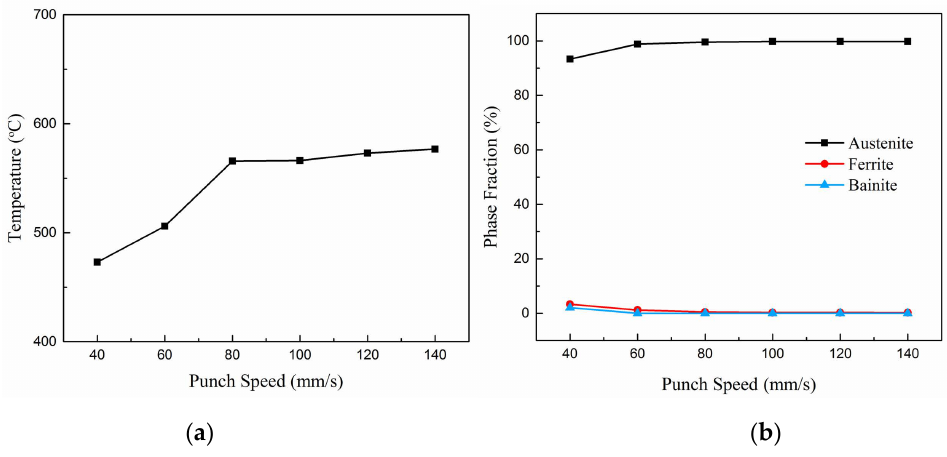
Figure 4. Variation of the minimum temperature ( a ) and phase fractions with the punch speeds ( b ).